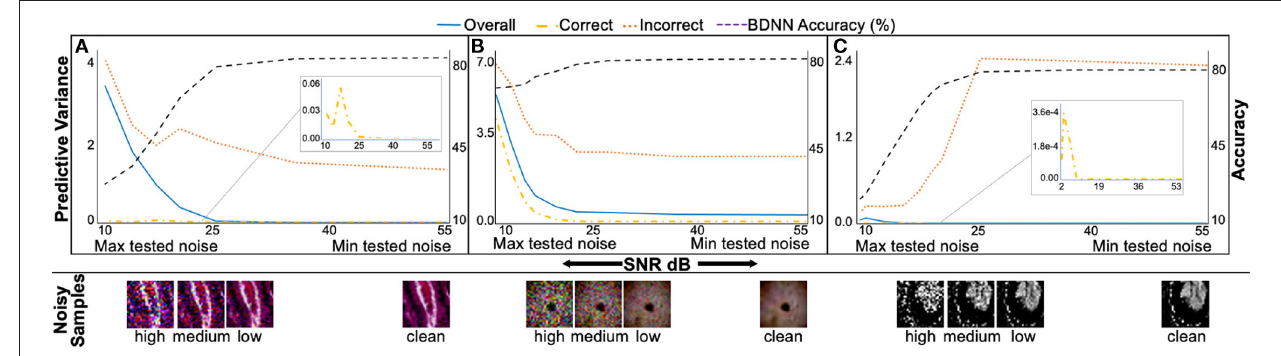
FIGURE 6 | The median predictive variance (left vertical axis) and BDNNs’ test accuracy values (right vertical axis) are plotted against varying levels of Gaussian noise added to the test datasets. In addition to the test accuracy in each sub-figure, three predictive variance curves, refer to the correct, incorrect, and combined (correct + incorrect) predictions. Inset in sub-figures shows the zoomed-in correct predictive variance trend. Sample test images from different noise levels are also presented. (A) , PathMNIST; (B) , DermaMNIST, and (C)